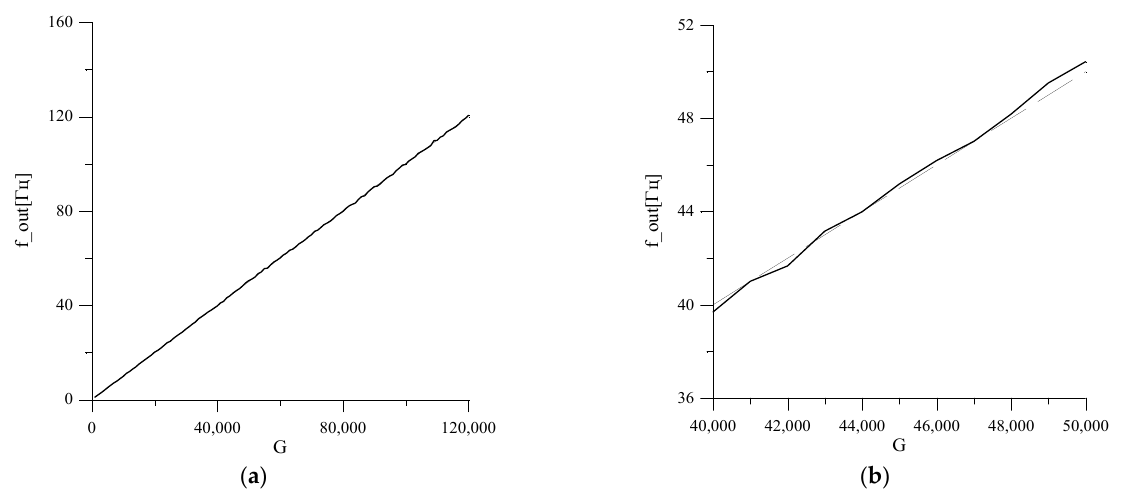
Figure 5. Output signal average frequency of the PPSG based on MAFG ( q = 6 ) , when ∆ G = 1000: ( a ) the dependence of the average frequency on the control code G; ( b ) the fragment of that dependence. G—control code value.